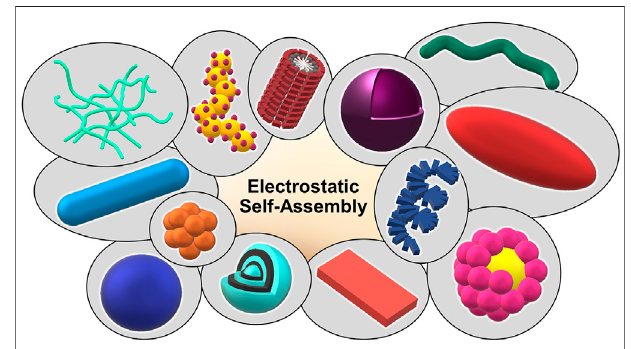
FIGURE 9 | Shape variety achieved by electrostatic self-assembly: networks, decorated wires, stacked micelles, vesicles, tubes, ellipsoids, helices, pomegranate-like structures, discs, onion-like structures, raspberry- like structures, spheres, and rods.